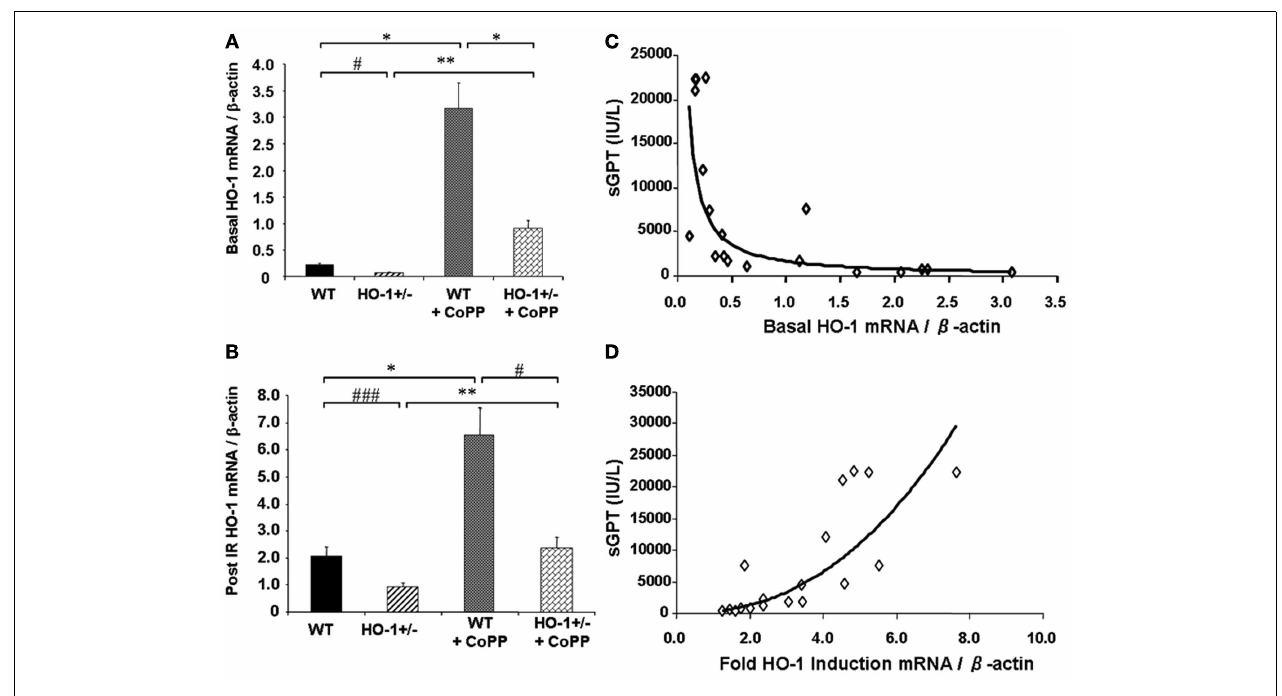
levels correlated negatively with post-IR serum GPT levels ( R 2 = 0.69, p < 0.0001) (D) HO-1 fold induction had a positive correlation with sGPT levels instead ( R 2 = 0.75, p = 0.0001).Taken fromTsuchihashi et al. (2006). Copyright 2006.The American Association of Immunologists, Inc.